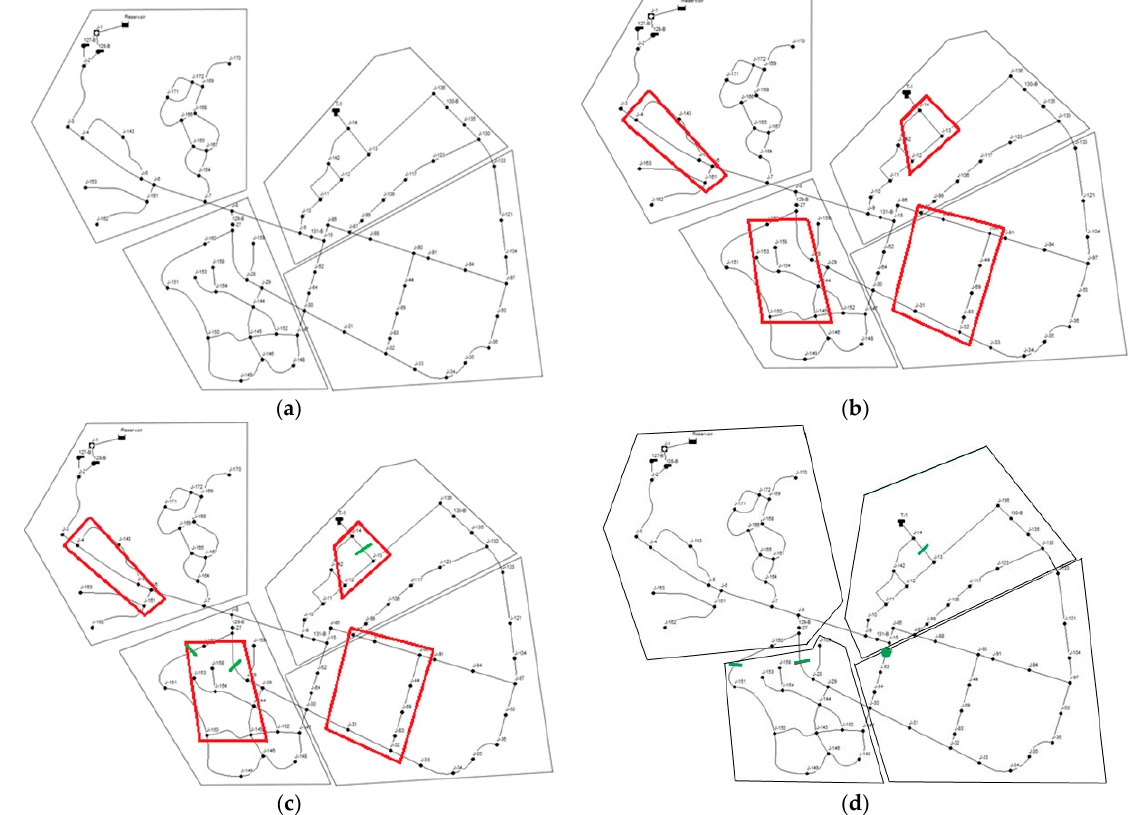
Figure 2. ( a ) Separation of Net22 into sub-regions using Geometric Partitioning; ( b ) the clusters with the highest average value for each sub-region using GMM-EM (red contour); ( c ) the pipes in which isolating valves are installed are colored in green; ( d ) splitting of Net22 into DMAs and the pipes with the green circle denote the selected pipes for PRV